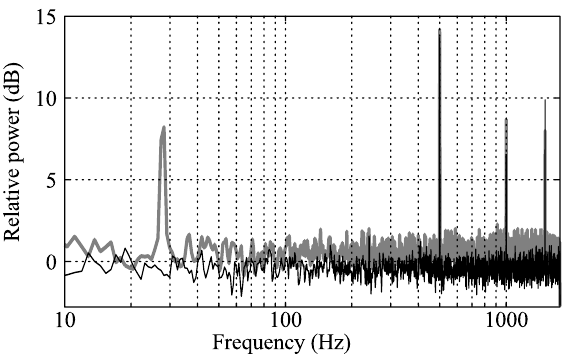
Figure 15. Power spectra of laser point measurements (arbitrary ordinate scale). Case 3 ( black ) and case 5 ( gray